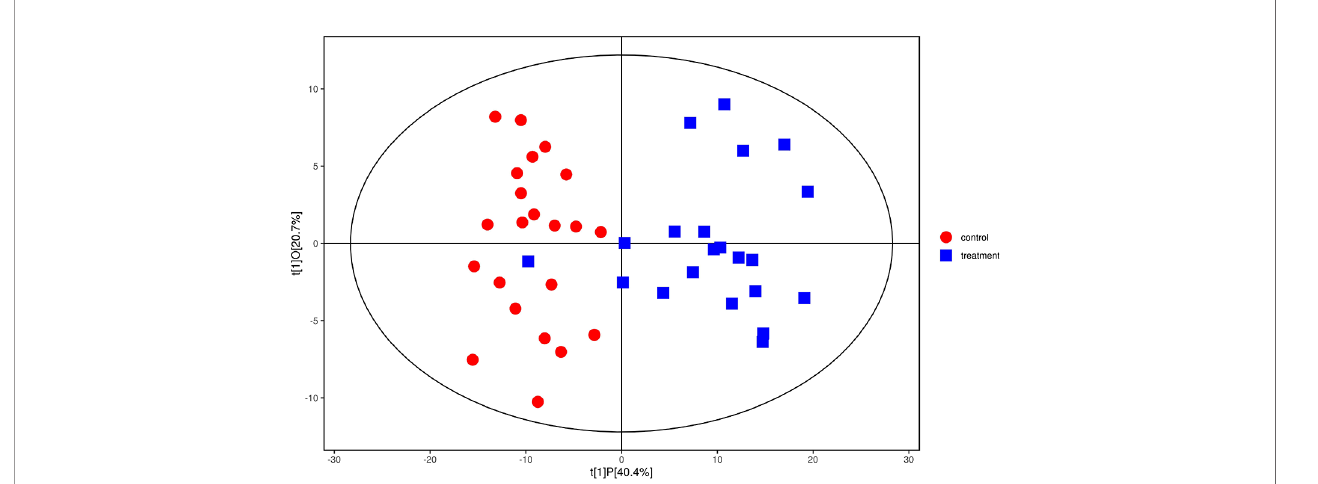
FIGURE 1 | Orthogonal partial least squares-discriminant analysis (OPLS-DA) model for group treatment (KS, blue) vs control (HC, red). Ions marked in blue show a signi fi cant difference in intensity between the KS and HC